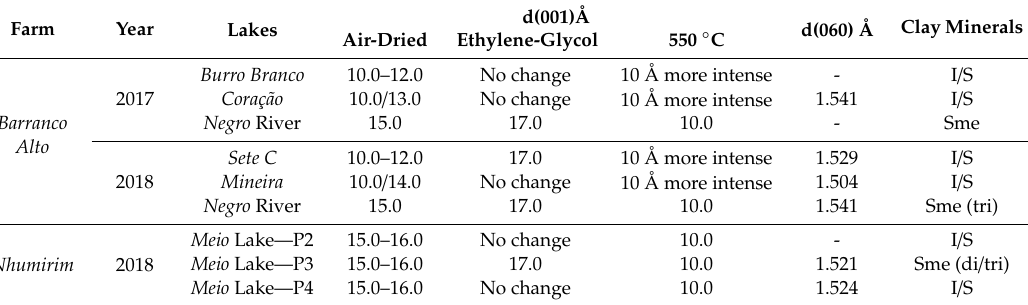
Table 8. Interpretation of 001 and 060 peaks from XRD analyses of the clay fraction from the Barranco Alto and Nhumirim farms (Figure 6). I / S—illite / smectite; Sme—smectite; di—dioctahedral; tri—trioctahedral; d—d-spacing; (-) not